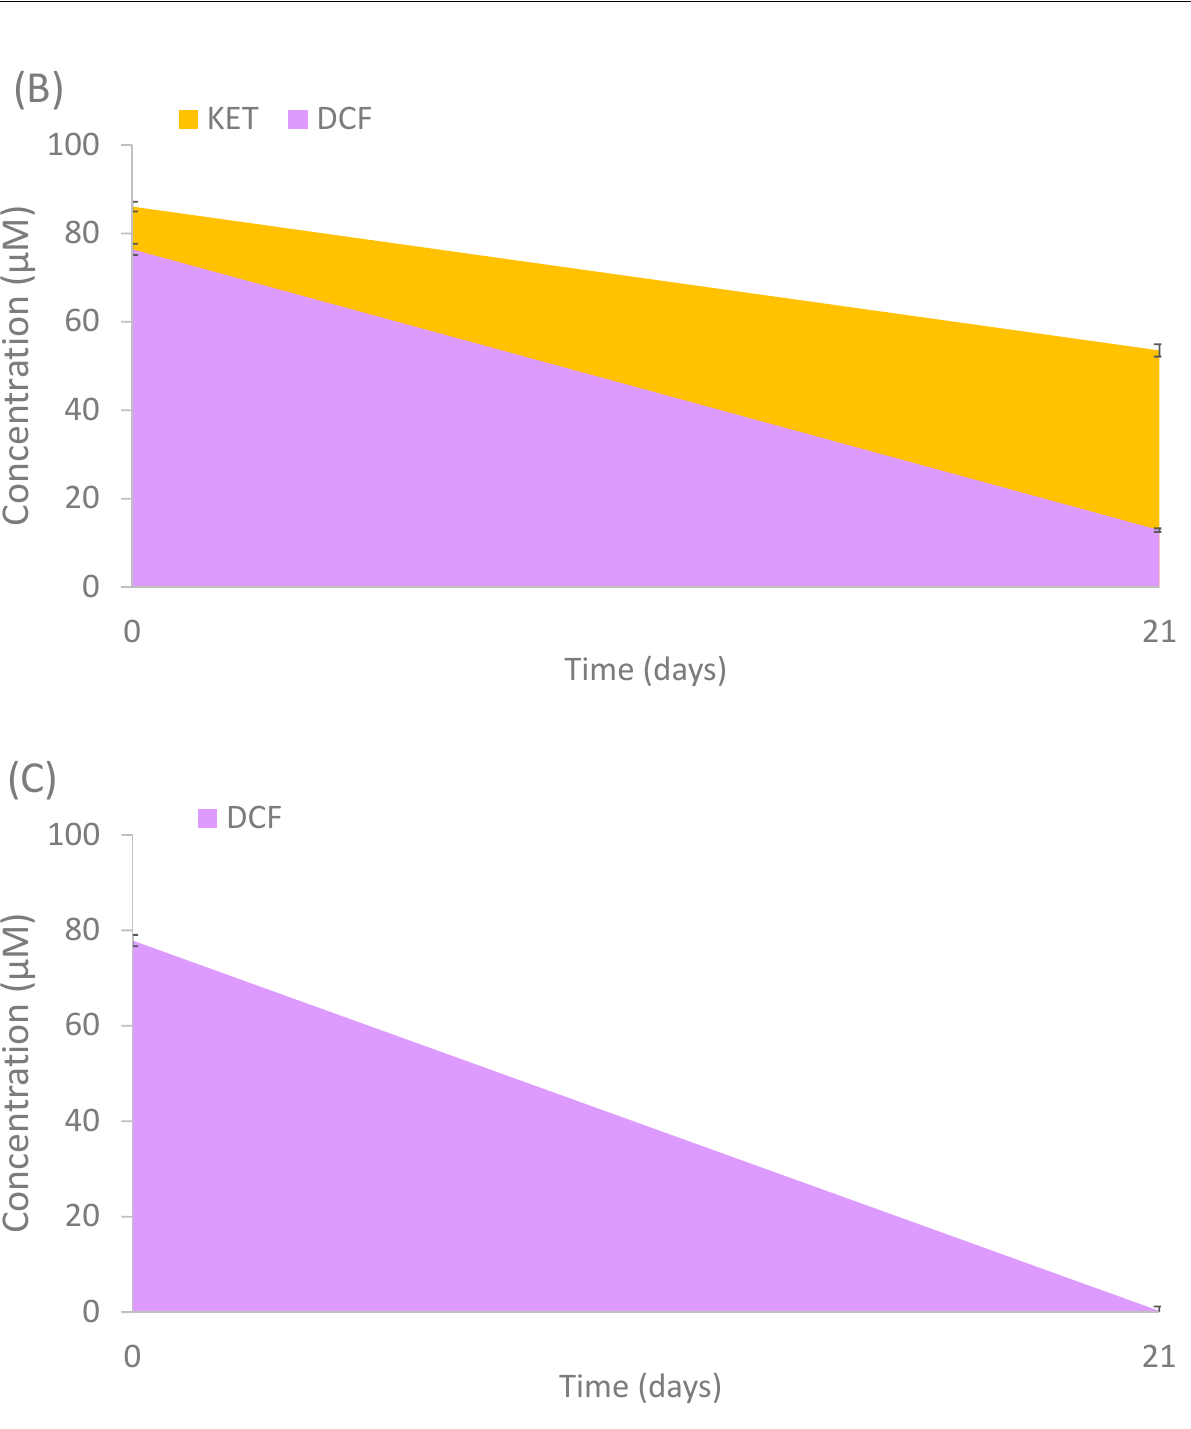
Figure 5. Degradation of selected PhACs by ( A ) Cladosporium cladosporioides , ( B ) Alternaria alternata and ( C ) Penicillium raistrickii . Mean values of triplicate measurements were calculated, and error bars represent standard deviation (n = 3).